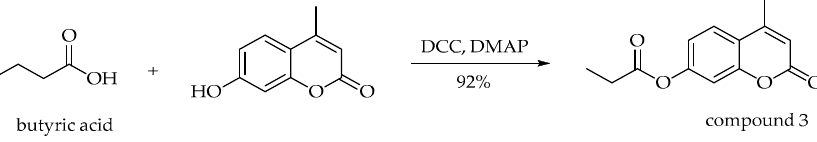
Figure 7. The synthesis of 4-methyl-2-oxo-2 H -chromen-7-yl propionate ( 3 ).